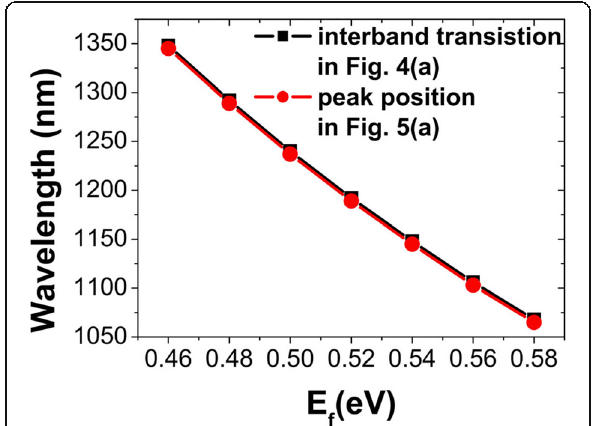
Fig. 6 a Positions of interband transition for different E